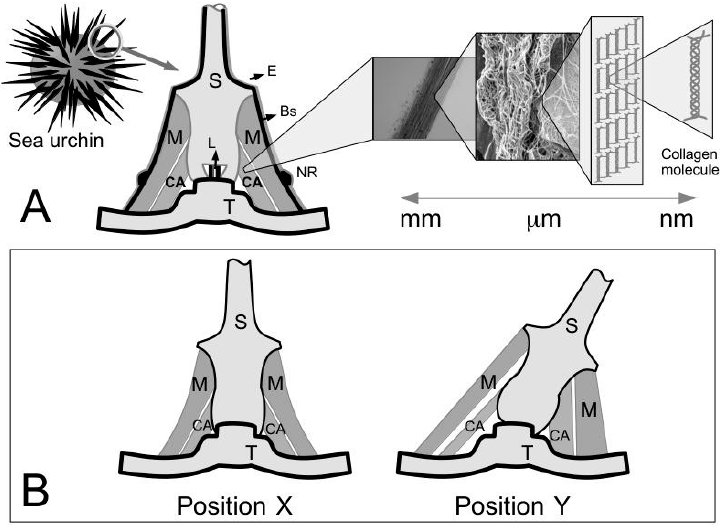
Figure 1. Sketches of the spine-test system of the sea urchin. ( A ) Cartoons of the sea urchin, represented by a sphere covered in spines, magnified view of the cross-section of the joint of the spine-test system and the hierarchical architecture of the catch apparatus (CA) tissue. The CA may be regarded as a ligamentous tissue as its ends are embedded in hard tissues of the spine and test; ( B ) Two positions, i.e., X and Y, of the spine. Symbols: S, spine; NR, nerve ring; Bs, basiepidermal nerve plexus; E, epidermis; L, central ligament; M, spine muscle; T, test. Adapted from Smith et al. [14], Hidaka et al. [15,16] and Motokawa and Fuchigami [17].